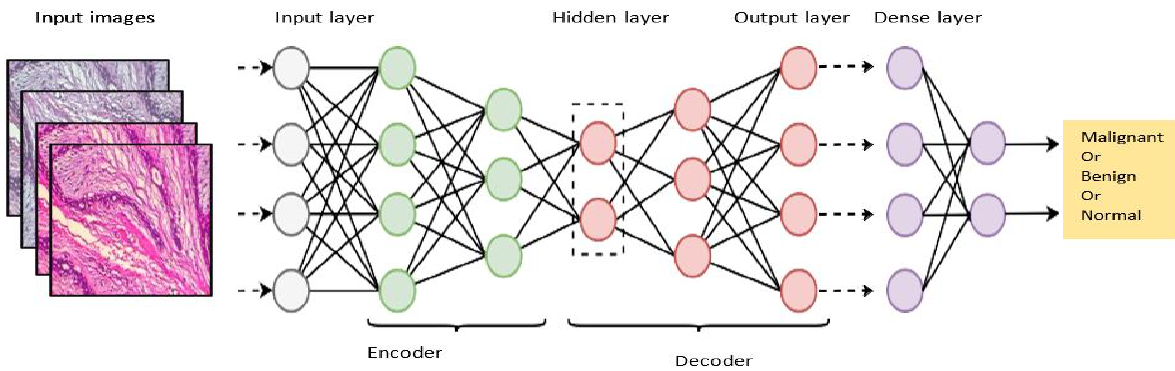
Figure 1. An illustration of the DBN for breast cancer detection.